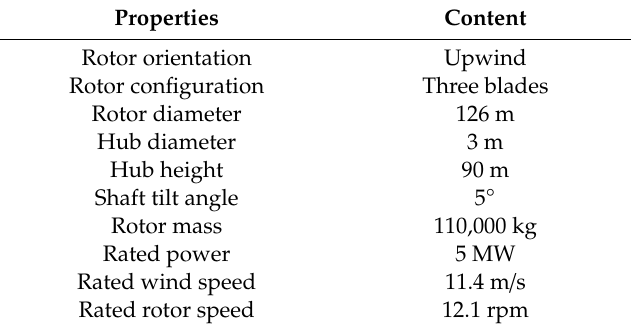
Table 1. PropertiesofNREL5MWbaselinewindturbine(NREL:NationalRenewableEnergyLaboratory).